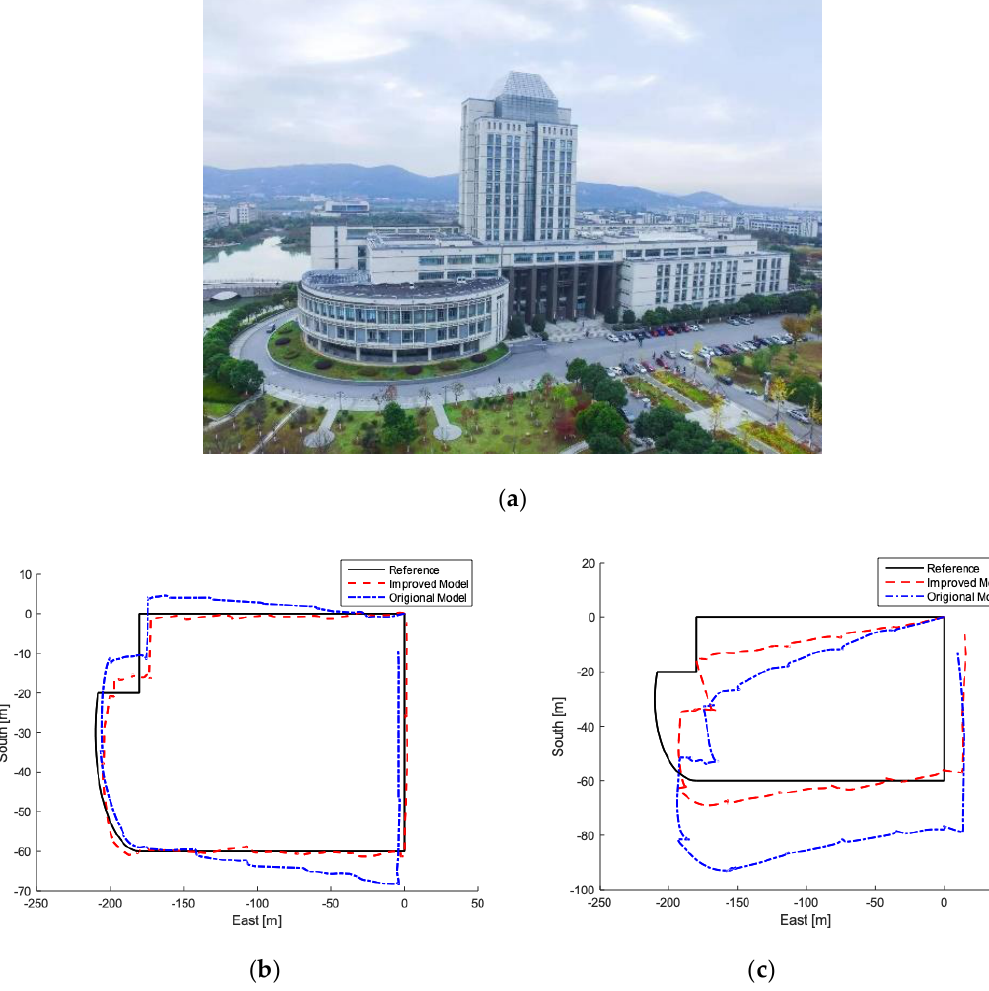
Figure 16. Typical experiment 2. ( a ) Experimental site; ( b ) Experimental results of Mti series MEMS-IMU from Xsens. ( c ) Experimental results of AH-100B.